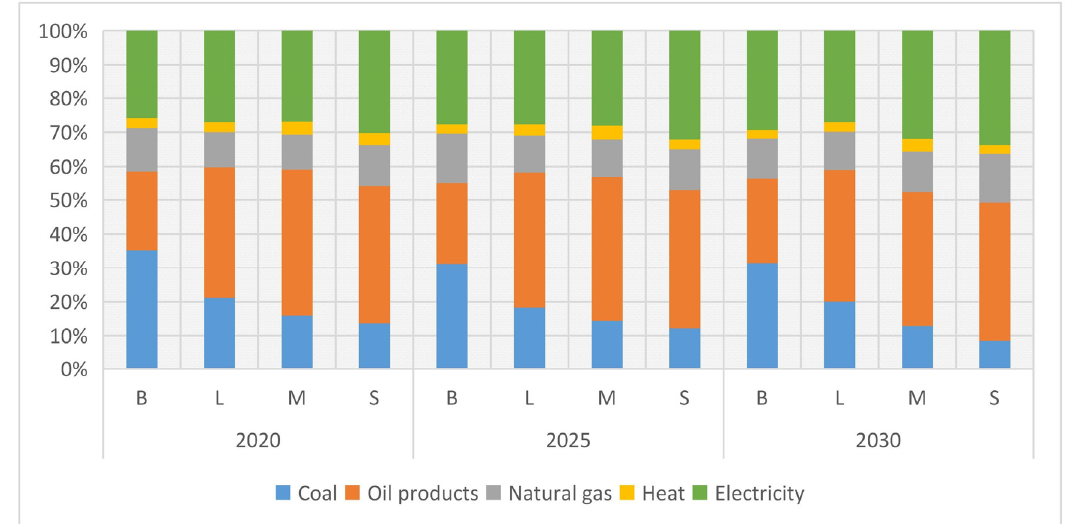
Figure 6. The proportion of final energy consumption by fuel type.